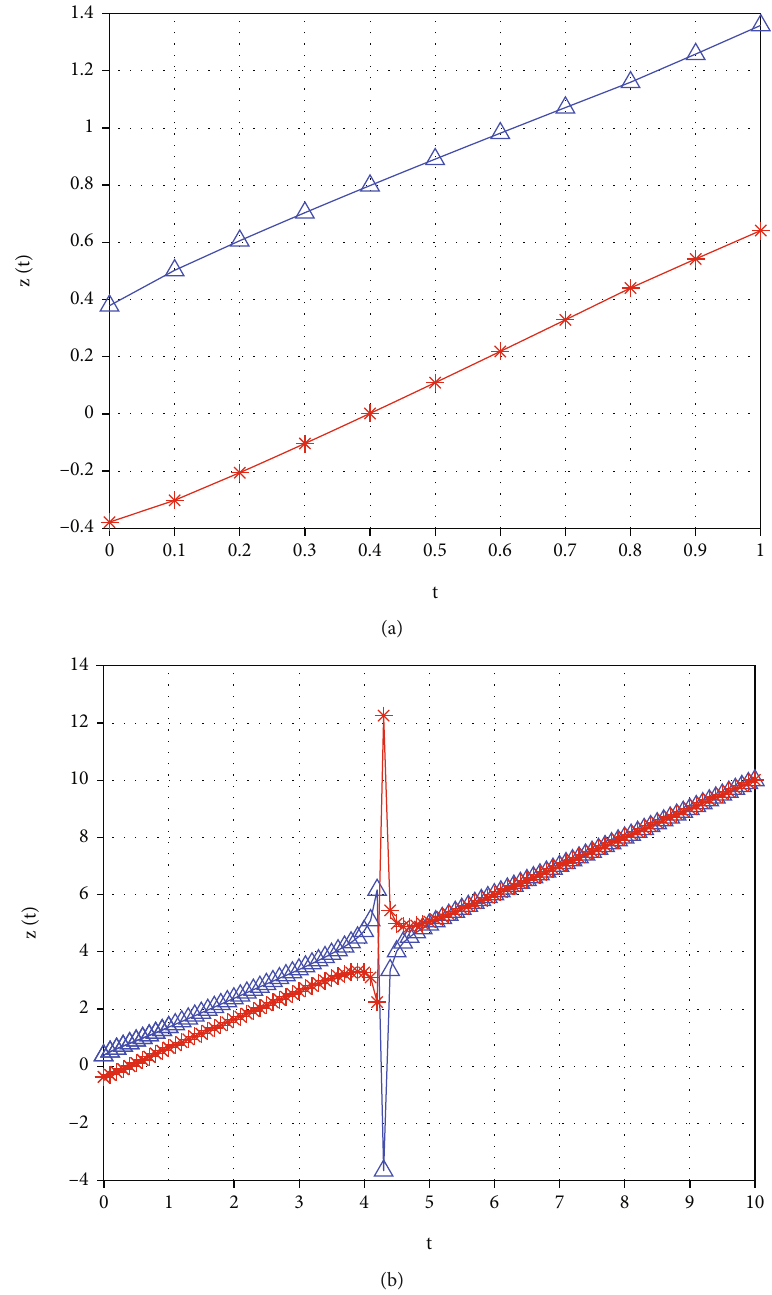
Figure 5: The graphic of the function z ð t Þ : (a) for t ∈ ½ 0, 1 (cid:2) and (b) for t ∈ ½ 0, 10 (cid:2)